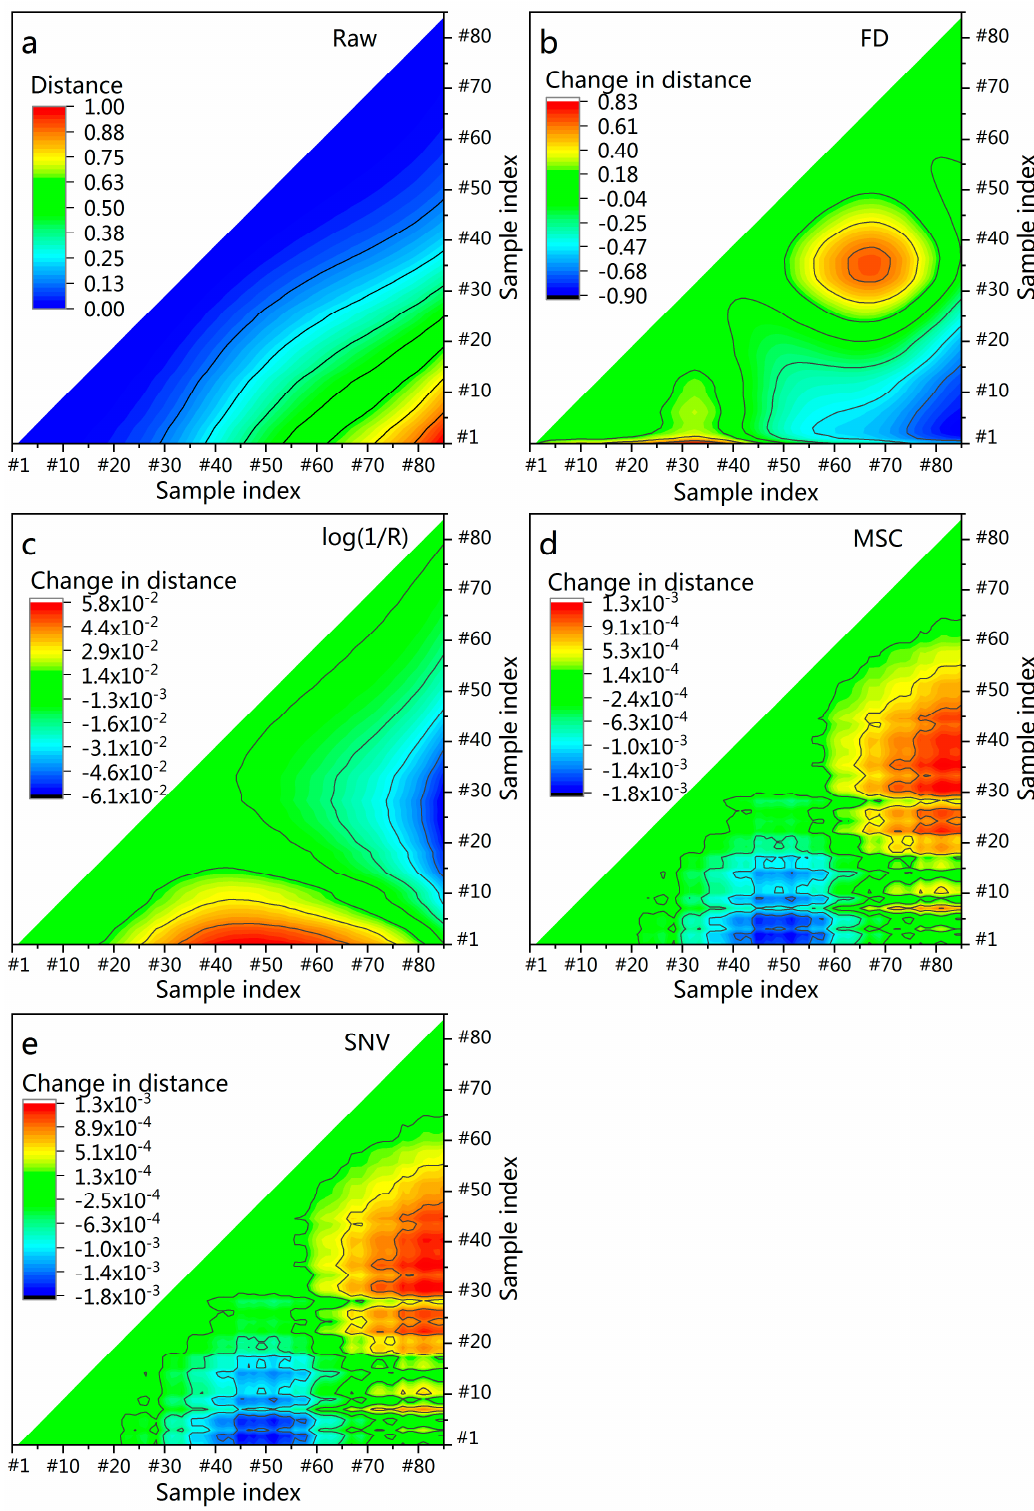
Figure 6. The Euclidean distance among samples of raw spectra ( a ) and the change in Euclidean distance after the spectra were pretreated by first derivative (FD) ( b ), logarithmic function (log(1/R)) ( c ), multiplicative scatter correction (MSC) ( d ), and standard normal variate (SNV) ( e ). All the calibration samples are sorted in ascending order according to SOM content and then numbered #1, #2, …, #85.